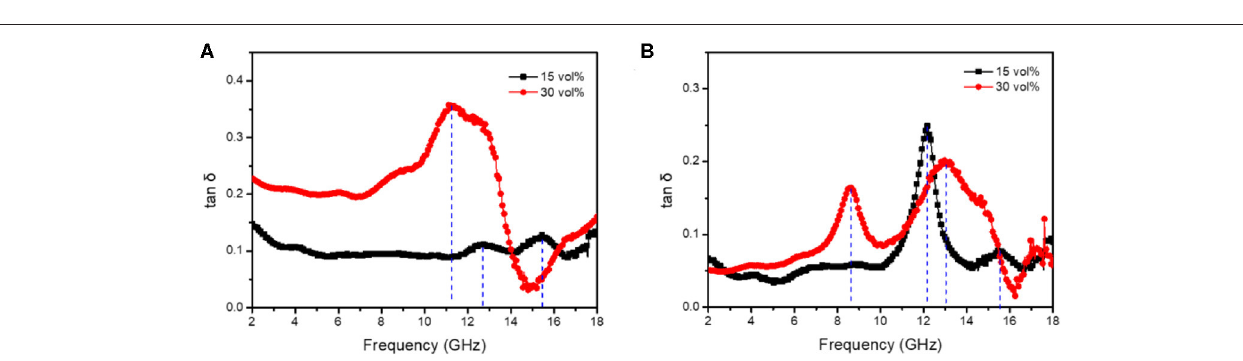
FIGURE 3 | Tangent loss of WC-1 (A) and WC-2 (B) with different filler